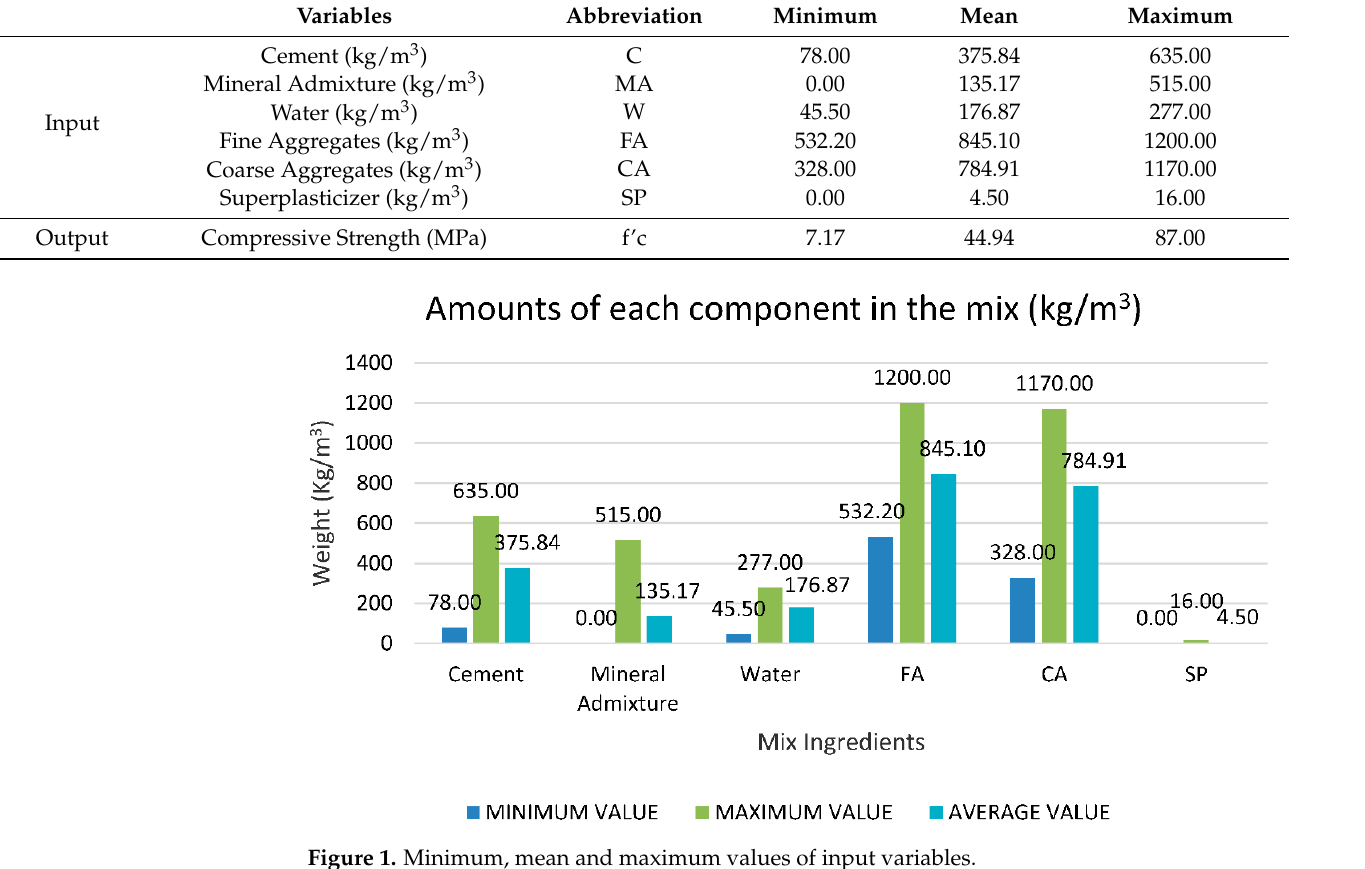
Figure 1. Minimum, mean and maximum values of input variables.